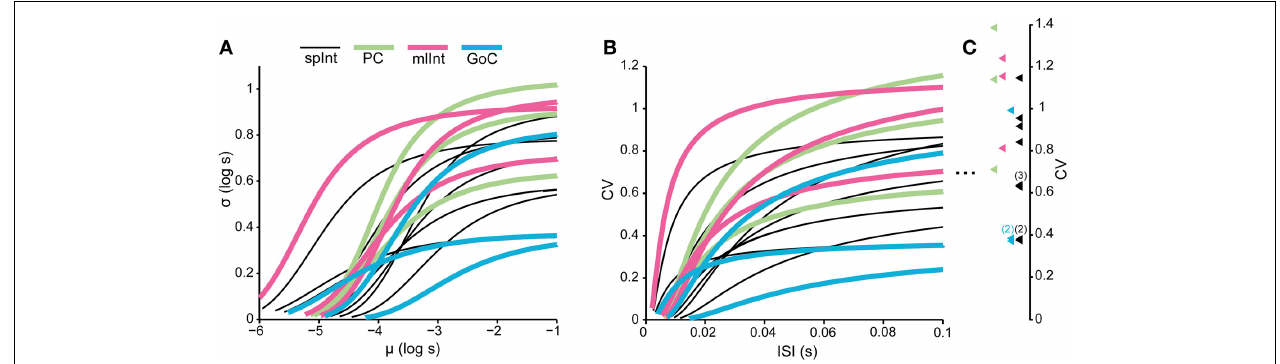
FIGURE 8 | Comparison between models of the different neuron types. The figure illustrates that the curves of different neuron types overlap extensively, such that the difference between two neurons of the same type is similar to the difference of two neurons of differing types. (A) Parametric curves between the mean and the standard deviation of the log-normal distributions of the models. The range of